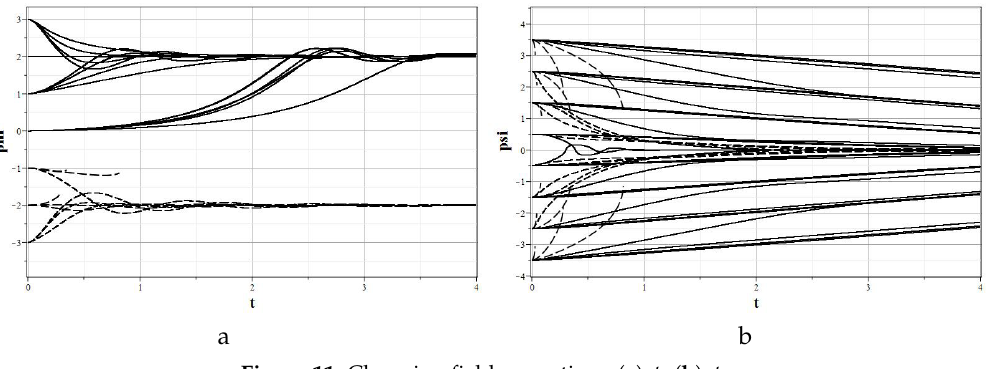
Figure 11. Changing fields over time: ( a ) φ , ( b ) ψ